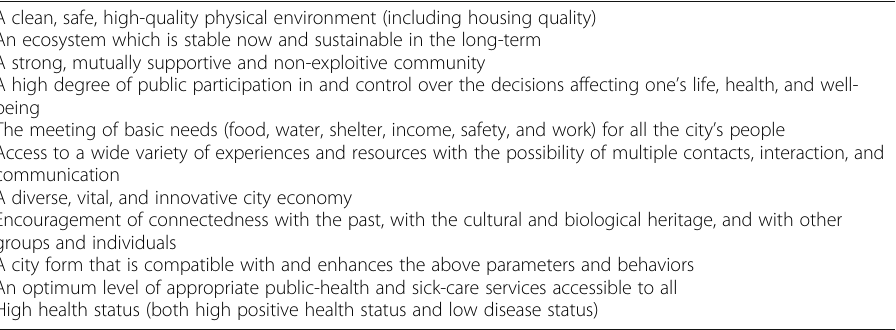
Table 1 Eleven parameters of a Healthy City by Hancock and Duhl